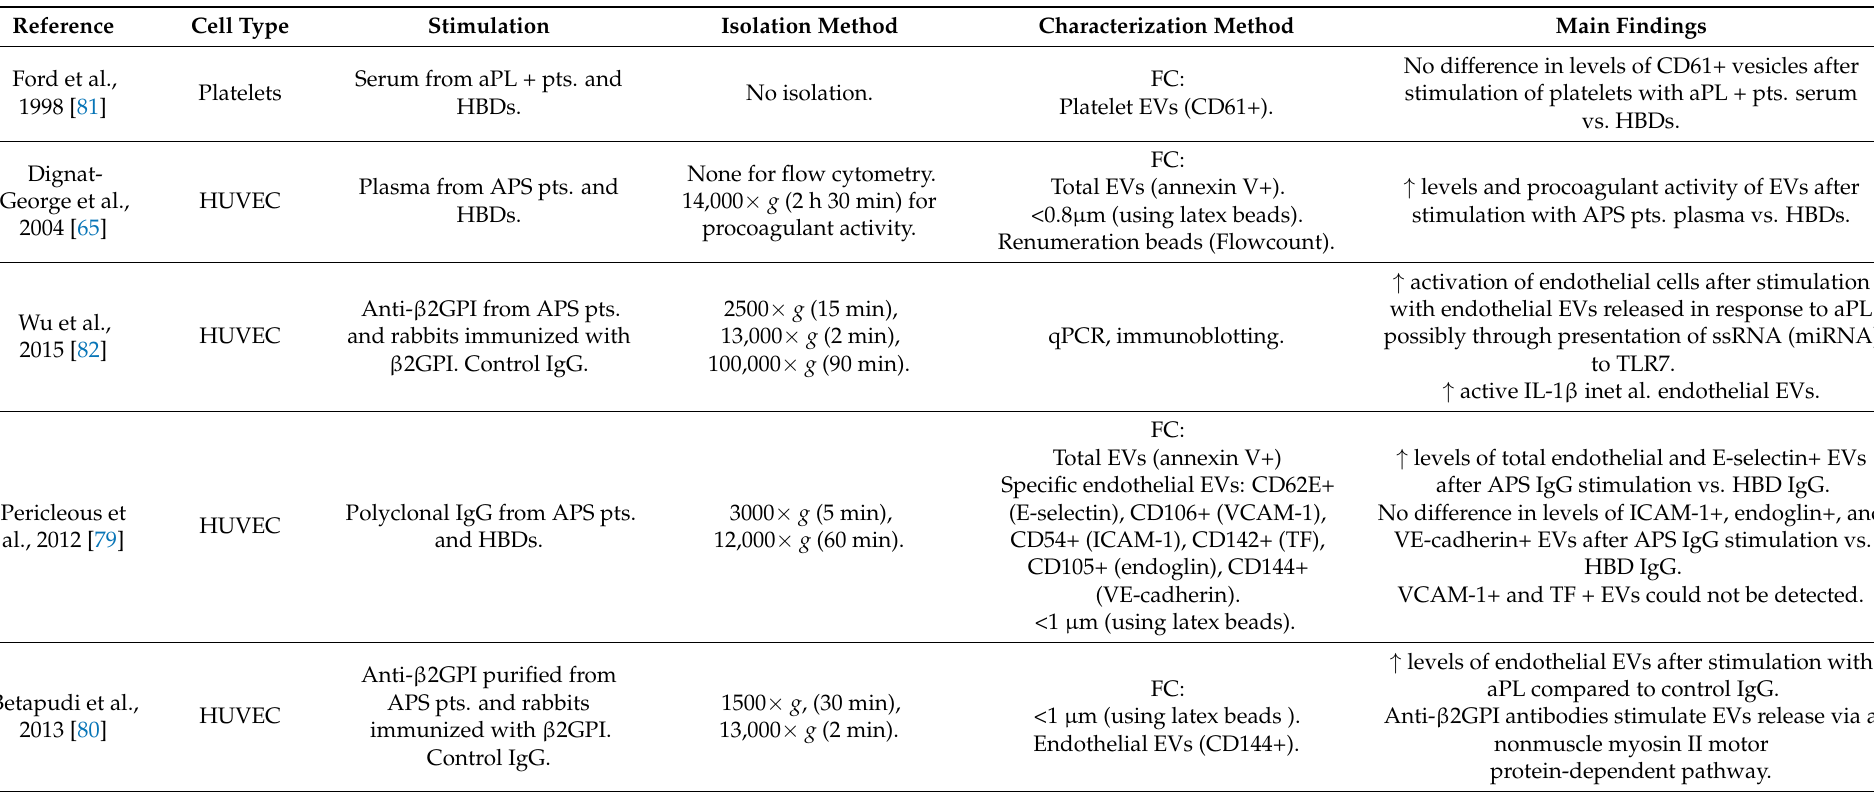
Table 2. Isolation, quantification and characterization of EVs derived from endothelial cells and platelets after stimulation with